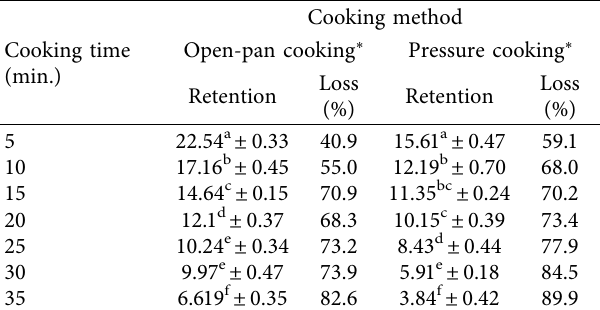
Table 2: Retention (mg/100g) and percent loss of ascorbic acid in Ethiopian green collard under each cooking